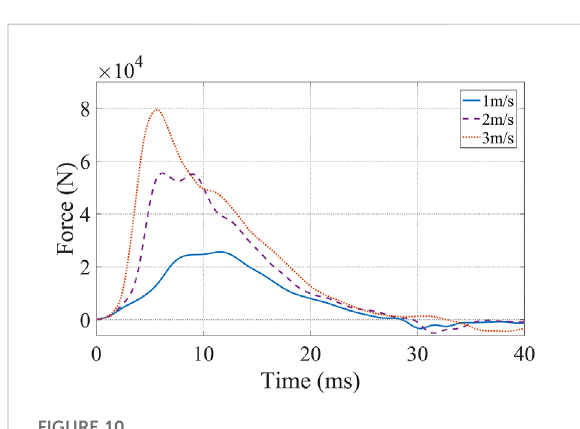
FIGURE 10 Experimental results of excited MREA at 3.0 A and more impact